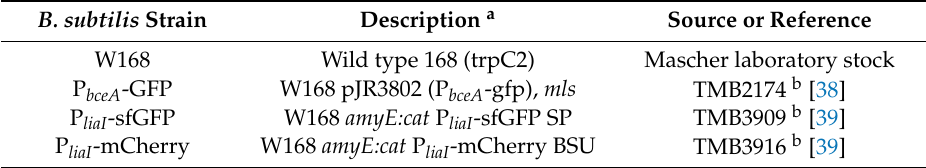
Table 1. Bacterial strains used in this